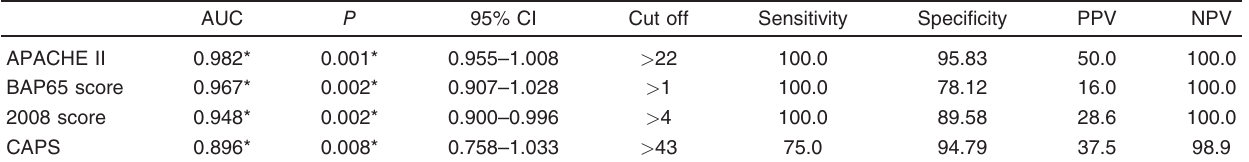
Table 3 Agreement (sensitivity and specificity) for Acute Physiology and Chronic Health Evaluation II, CAPS, BAP65, and 2008 scores to predict mortality